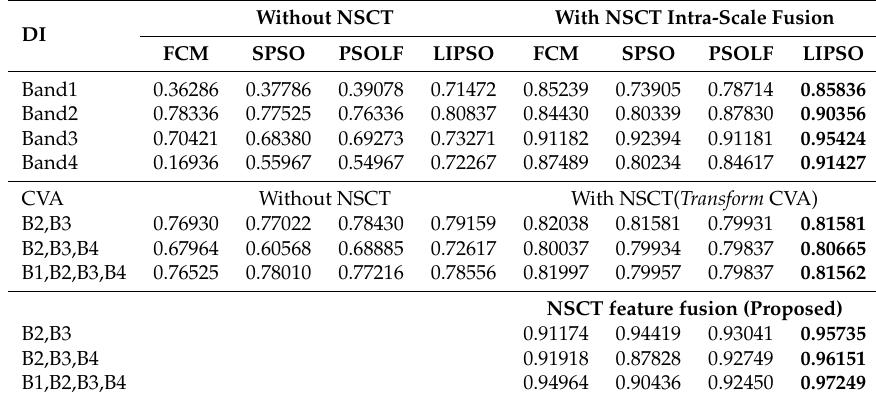
Table 2. Kappa statistic obtained for FCM [3], SPSO [47], PSOLF [43], LIPSO (proposed) of Itezhi, Tezhi Reservoir, Zambia data set.